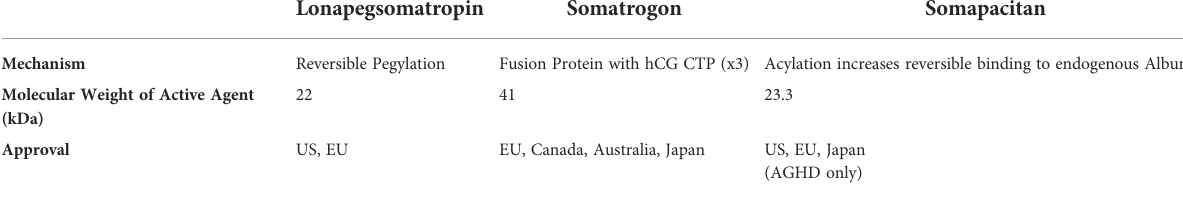
TABLE 1 Long-acting growth hormone characteristics and approval